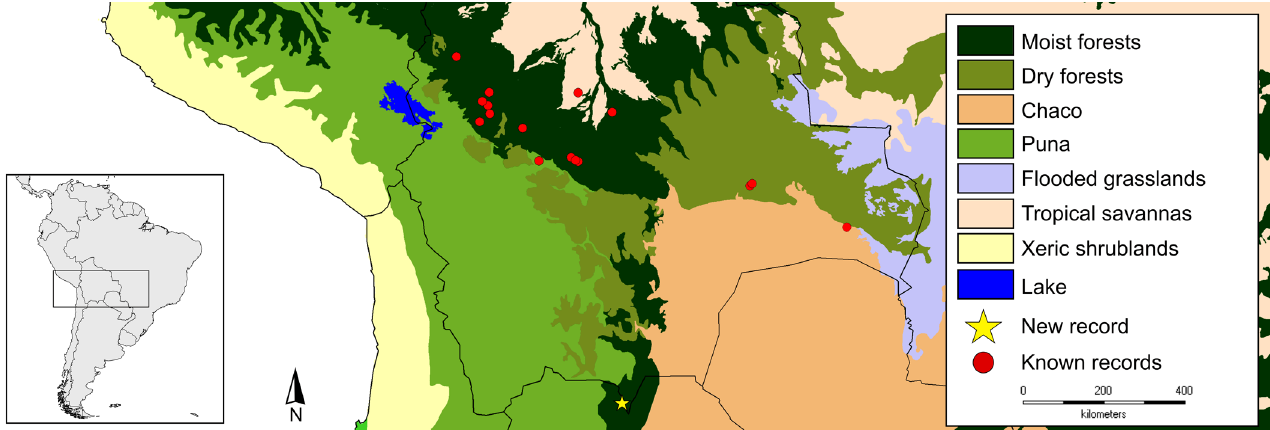
Memphis boliviana (Druce, 1877) (sensu Olson et al.